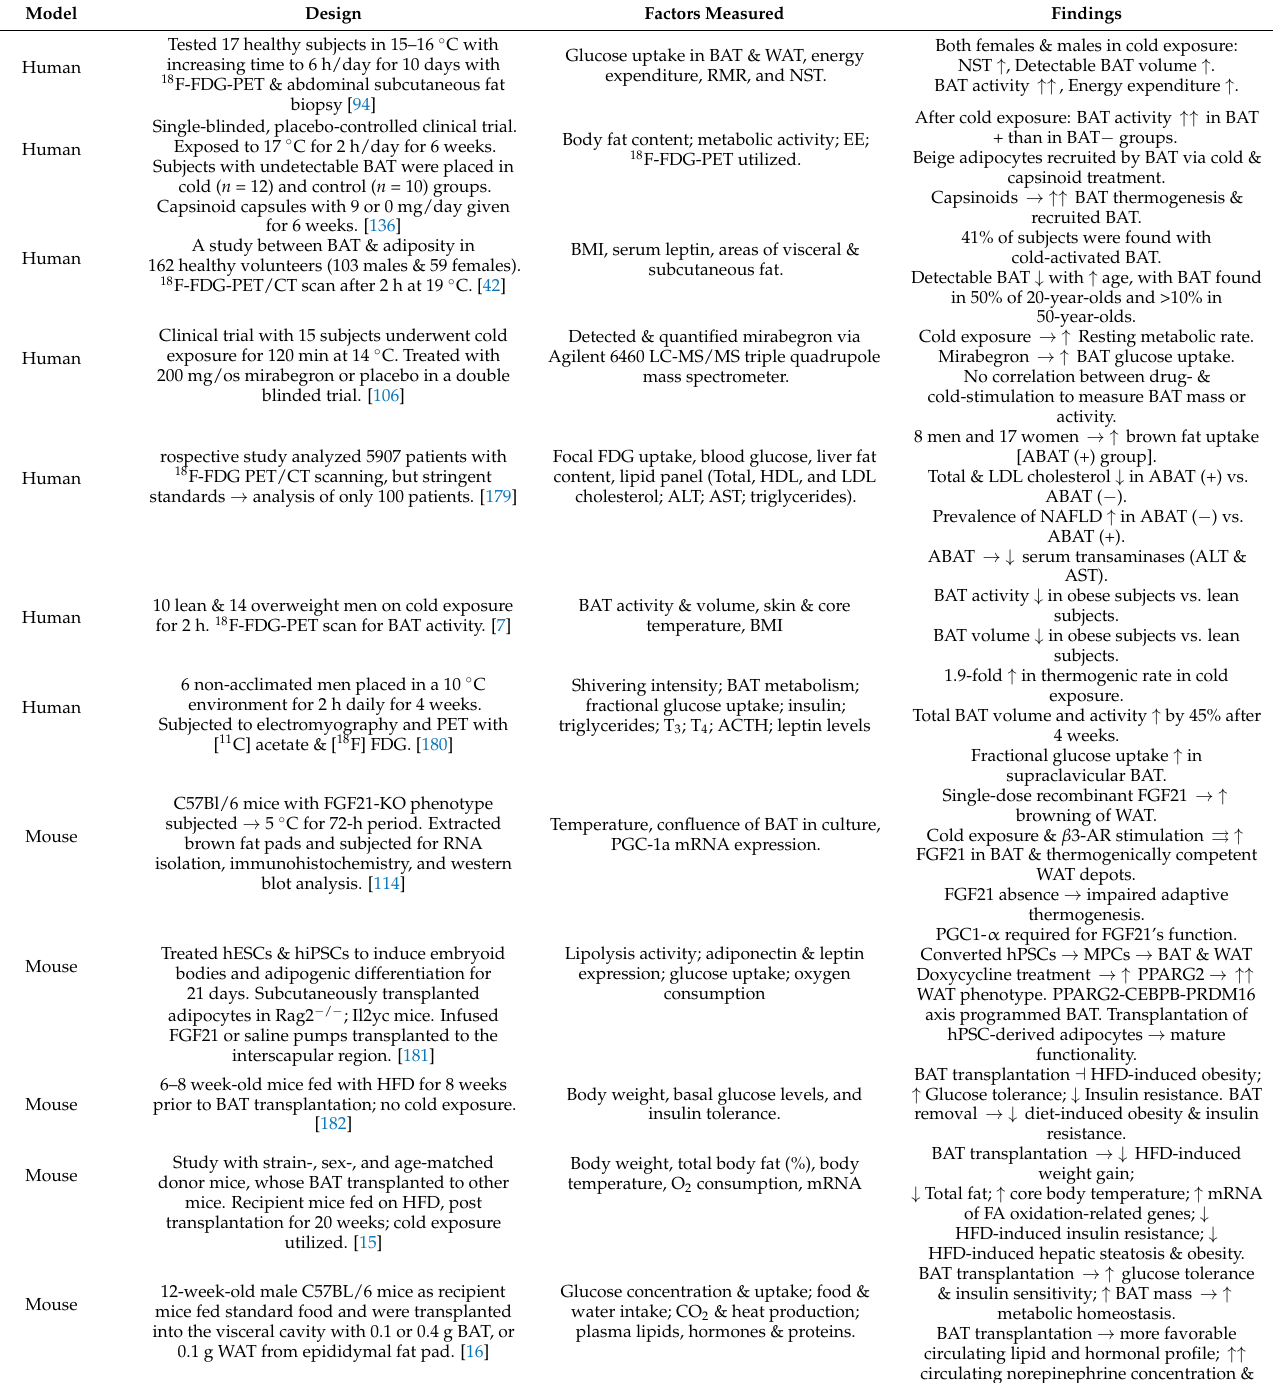
Table 2. Adipose browning studies in human and rodent